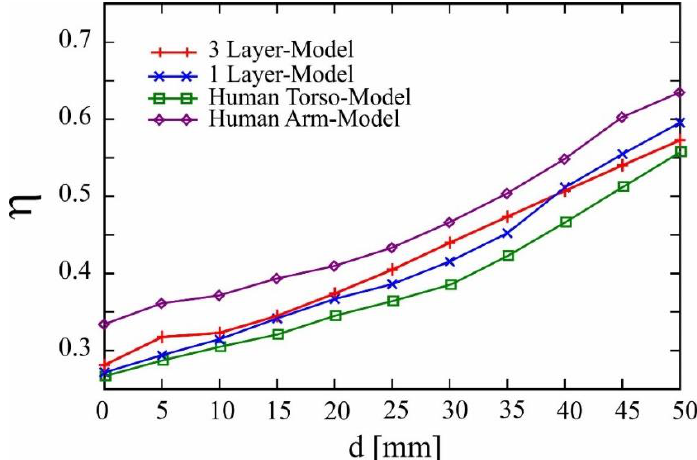
Figure 21. Variation of η with respect to the distance from the body phantom for different body Figure 21. Variation of  with respect to the distance from the body phantom for different body phantom Figure 21. Variation of  with respect to the distance from the body phantom for different body phantom models. Figure 21. Variation of  with respect to the distance from the body phantom for different body phantom models. phantom models.